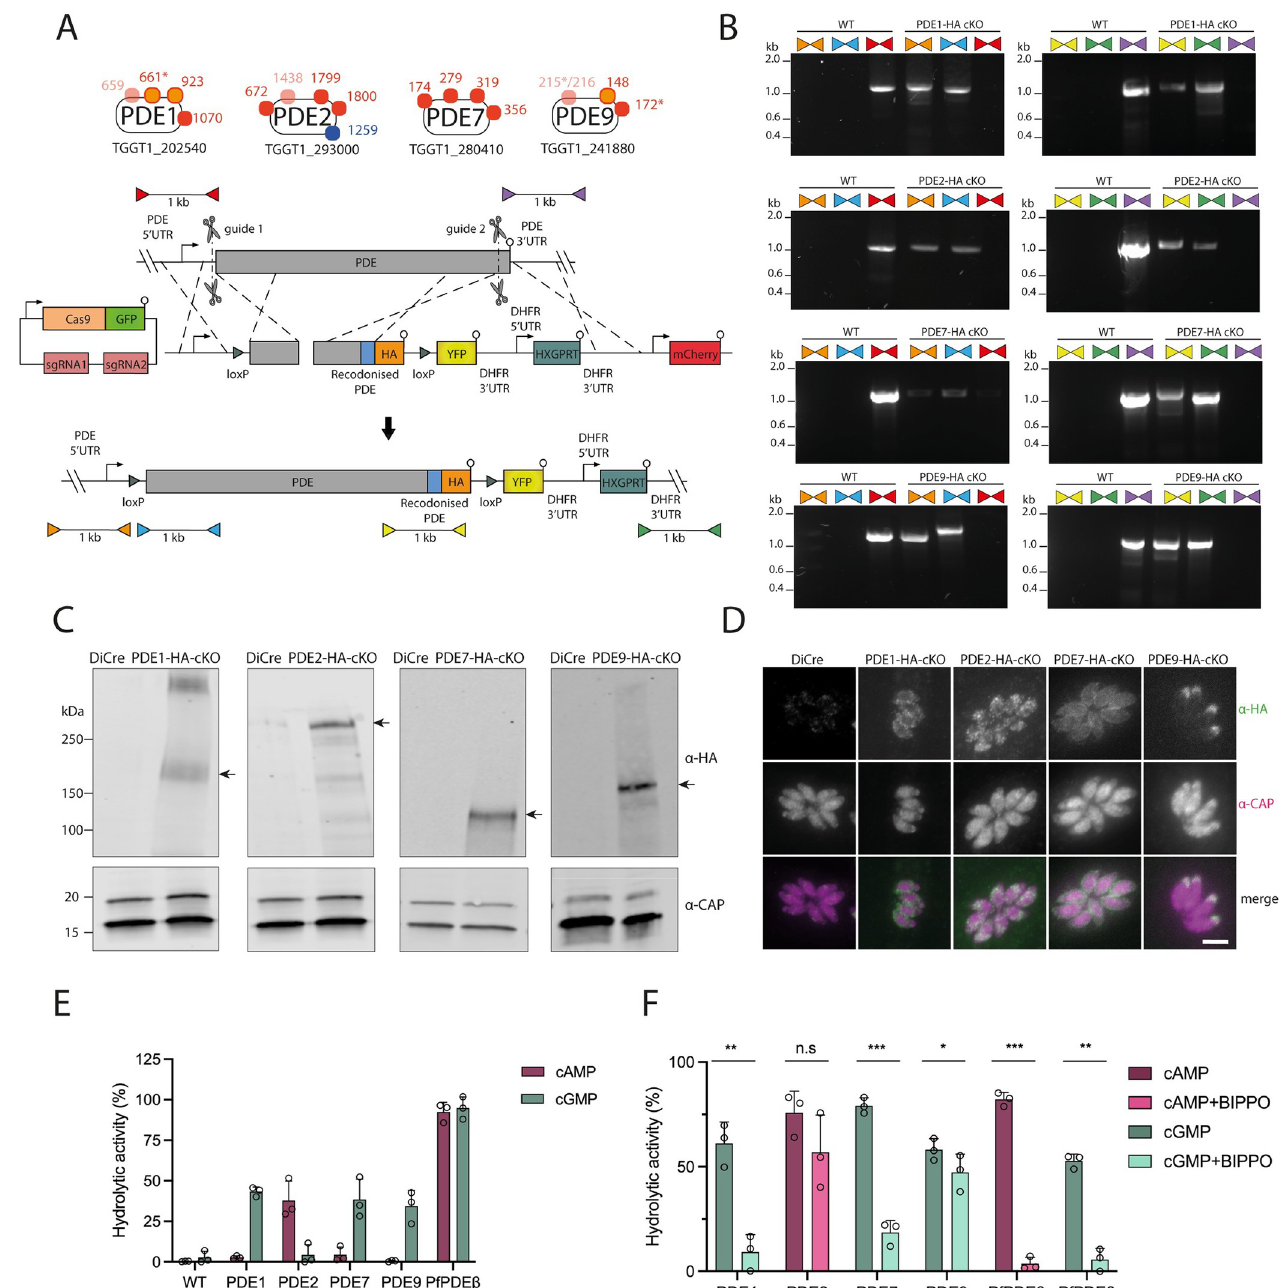
Fig 5. Candidate PDEs occupy distinct subcellular localisations and are differentially inhibited by BIPPO (A) Schematic representation of the PDEs identified in the timecourse phosphoproteome (see Fig 2E) and the strategy used to generate the conditional PDE knockout lines. CRISPR/Cas9 was used to generate two cuts in the gene and two separate repair templates were provided to integrate one loxP site (green triangle) upstream of the PDE gene, and another repair template to tag the PDE with a C-terminal HA epitope tag (orange) and introduce a second loxP site, a YFP sequence and the HXGPRT cassette. Scissors represent Cas9 cleavage sites and lollipops depict stop codons. Coloured triangles represent primer pairs used to detect WT, 5’ integration and 3’ integration loci for 5’ loxP integration (red, orange and blue respectively) and 3’ tagging (purple, yellow and green respectively). (B) PCR analysis showing correct 5’ and 3’ integration of the 5’ loxP site and 3’ tagging repair templates, and lack of WT locus in PDE1, PDE2, PDE7 and PDE9 cKO lines. Coloured triangles represent primer pairs as illustrated in Fig 5A (C) Western blot analysis of parental DiCre and HA-tagged PDE1, PDE2, PDE7 and PDE9 cKO parasites probed with α -HA antibodies showing migration of the PDEs at their expected molecular weights as depicted by arrows. A non-specific band > 250 kDa is observed in the PDE1-HA cKO line. Blots were probed with α -CAP antibodies as a loading control. (D) Immunofluorescence analysis of DiCre and HA-tagged PDE1, PDE2, PDE7 and PDE9 cKO lines probing with α -HA (red) and α -CAP (green) antibodies. Scale bar, 5 μ m. (E) Hydrolytic activity of